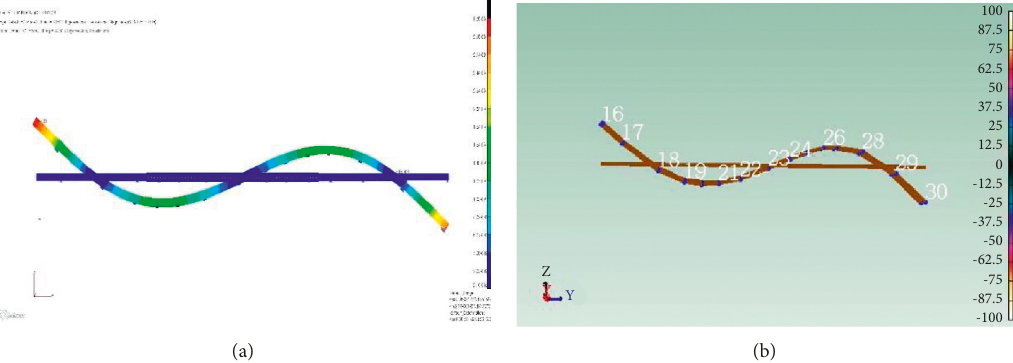
Figure 13: Vertical bending modal shape (3 nodes), full loading condition. (a) Numerical prediction. (b) Measurement results.